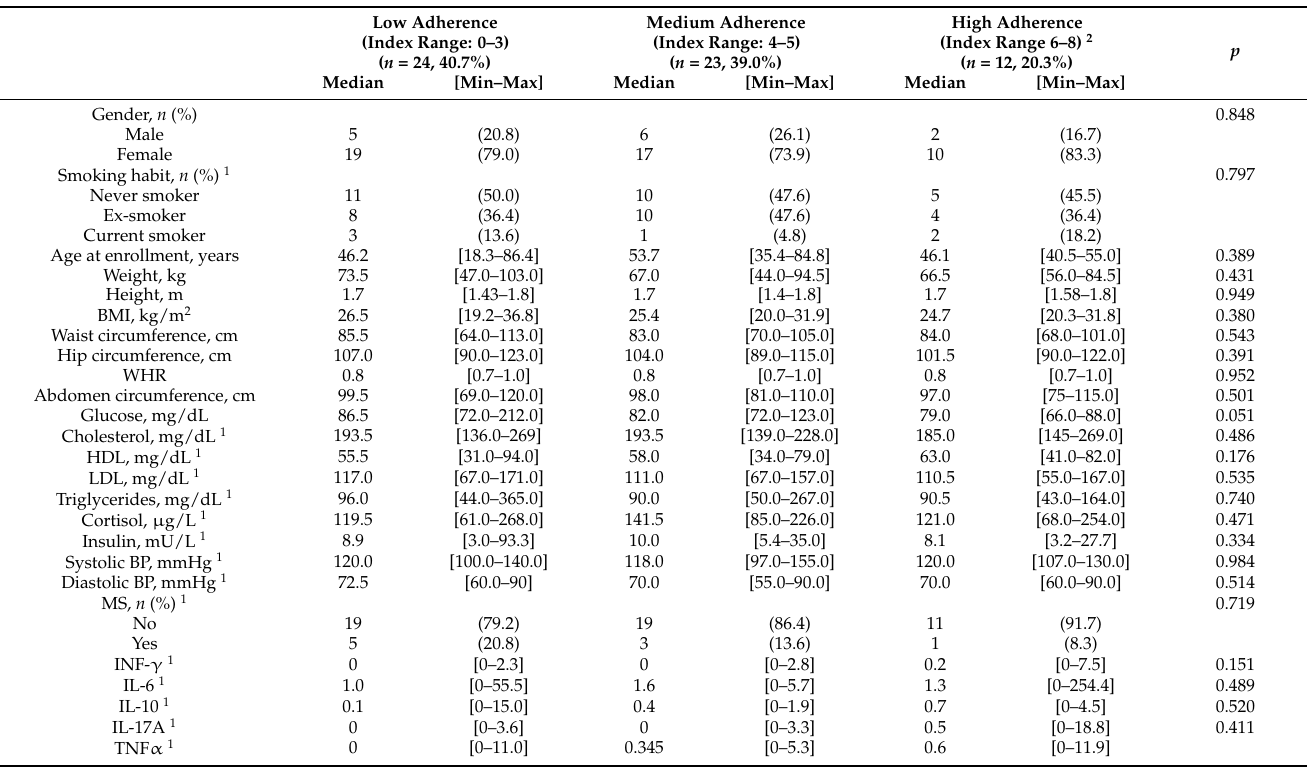
Table 2. Distribution at baseline of anthropometric, biochemical, and immunological characteristics by Italian Mediterranean Index tertiles ( n = 59). Italy,